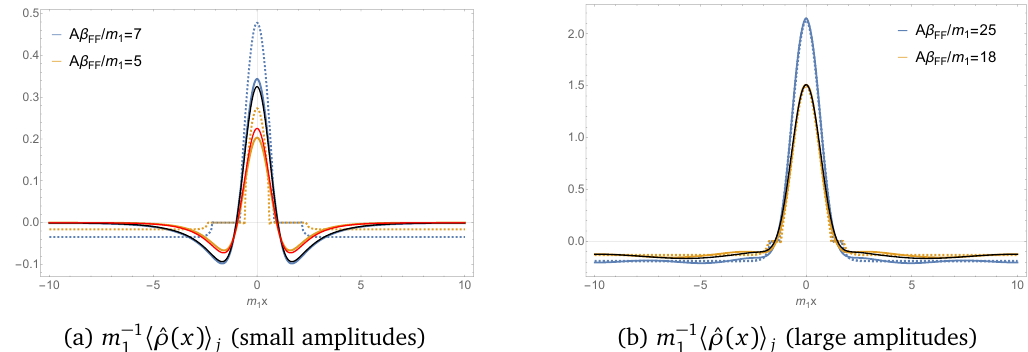
Figure 4.5: The QFT expectation value of 〈 ˆ ρ ( x ) 〉 at the free fermion point from j LDA and the exact free fermion computation for four different amplitudes of the ex- / m = 5, A β / m = 7, and A β / m = 18, A β / m = 25. The ternal field: A β FF 1 FF 1 FF 1 FF 1 σ = 2 / 3 in all cases. The coloured continu- bump-width in the external field is m 1 ous lines correspond to the free fermion result, while the dashed ones to LDA. For / m = 7, and A β / m = 18 the TCSA profiles with continuous black lines are A β FF 1 FF 1 also shown. For the TCSA curves extrapolation was used based on the data with cut- = 24,26,28 and 30. The mass scale m offs e is understood as twice the fermion (cid:112) c 1 ϕ ( x ) 〉 / π for mass M . In subfigure (a) the rescaled Klein–Gordon initial profile 〈 ∂ x j / m = 5 is also displayed with a continuous red A β FF 1